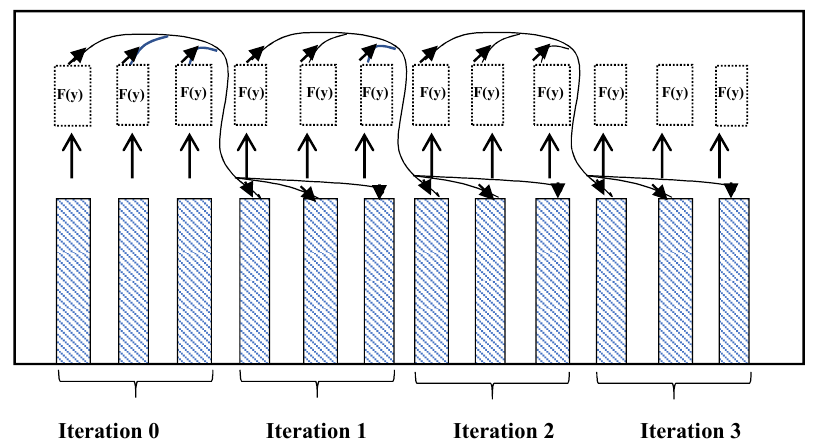
Figure 2. PAB execution and scheduling scheme on 3 processing units. The result value of each iteration is calculated and then the F value for the next iteration is computed. Those values will be propagated to the other processing units for the next iteration. In each iteration, 3 points of the problem are solved.